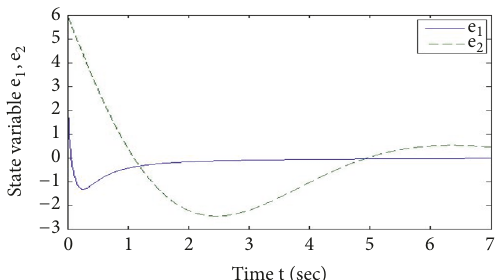
Figure 1: Target tracking process for the first step.